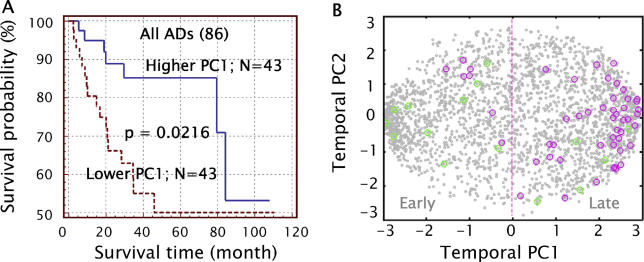
Independent Validation with Separate Human Lung AD Dataset from Beer et al. [
21]
(A) Survival analyses of 86 human lung ADs by K-M plot with patients separated into two groups by the mouse PC1 median point (
p = 0.0216).
(B) The profiles of the 91 genes (26 cancer up-regulated [green circles] and 65 cancer down-regulated [magenta circles]) among 2,653 mouse lung developmental gene profiles.